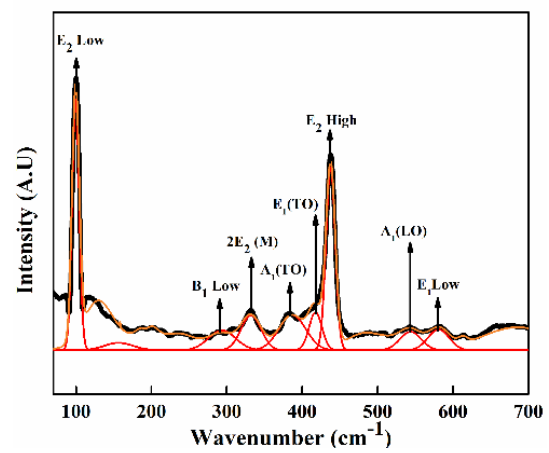
Figure 6. Raman spectrum of ZnO NPs.